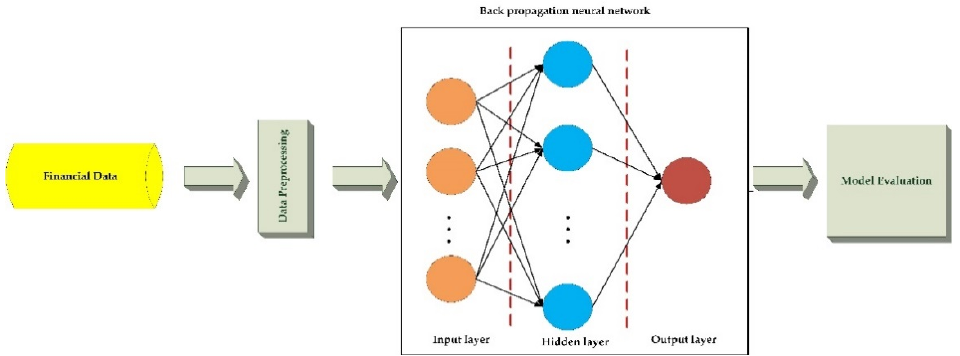
Figure 1. Back-propagation neural network.